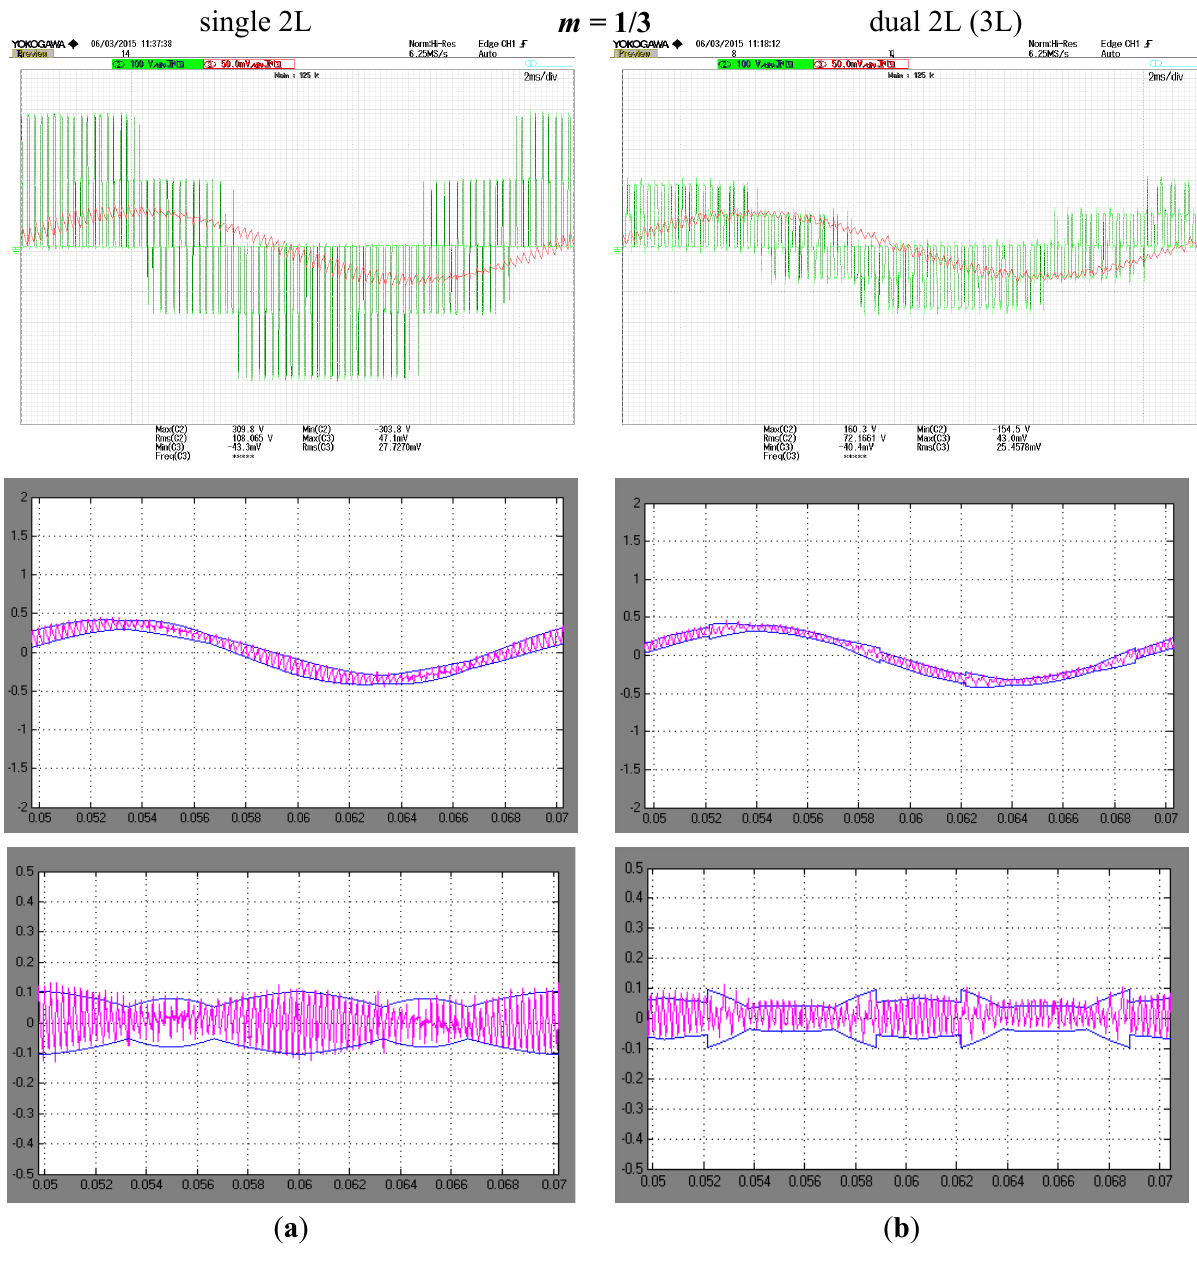
Figure 7. Experimental results: details of the output voltage and current waveforms from the oscilloscope, instantaneous output current with calculated peak-to-peak amplitude envelopes, and detail of current ripple with envelopes for m = 1/3: ( a ) single-2L inverter; ( b ) dual-2L (3L)